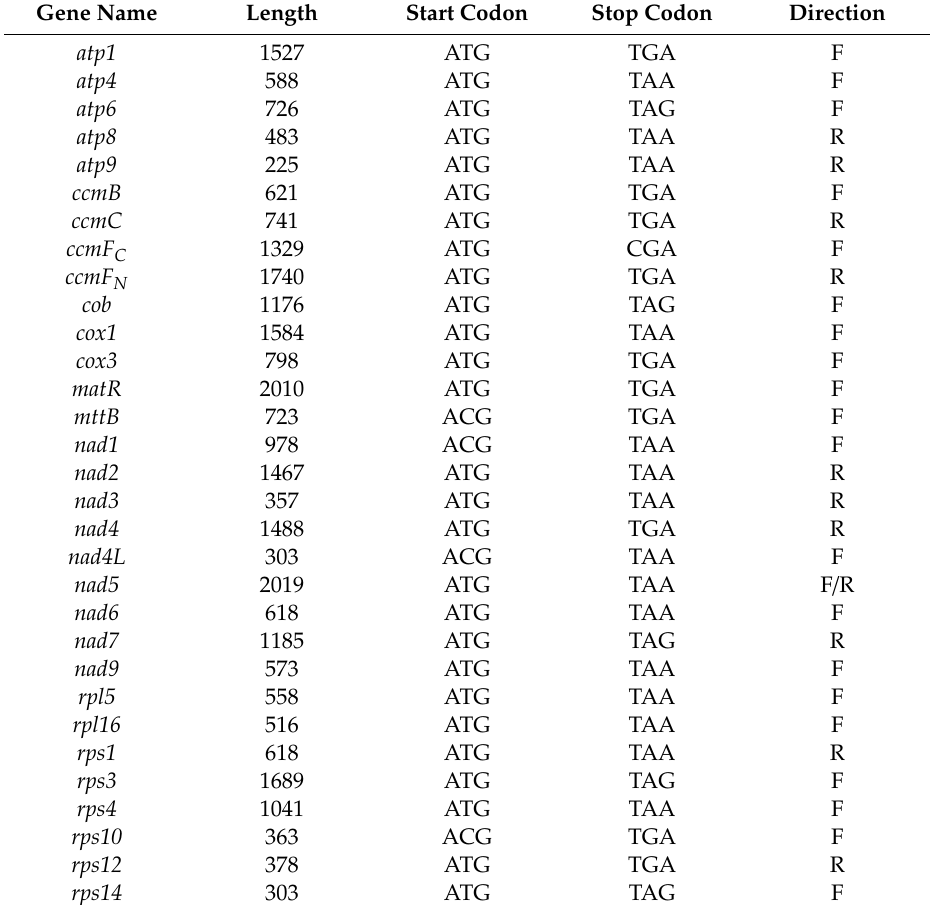
Table 3. Gene profile and organization of PCGs in P. vulgaris